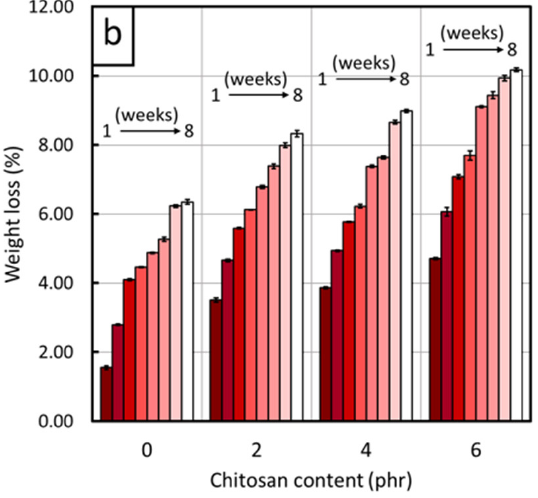
Figure 7. Percentage weight loss ( % weight loss ) of ( a ) CS/R-VNRL composites and ( b ) CS/RP-VNRL composites, with varying CS contents of 0, 2, 4, and 6 phr. The % weight loss was observed for a total of 8 weeks. Error bars indicate ± standard deviation.